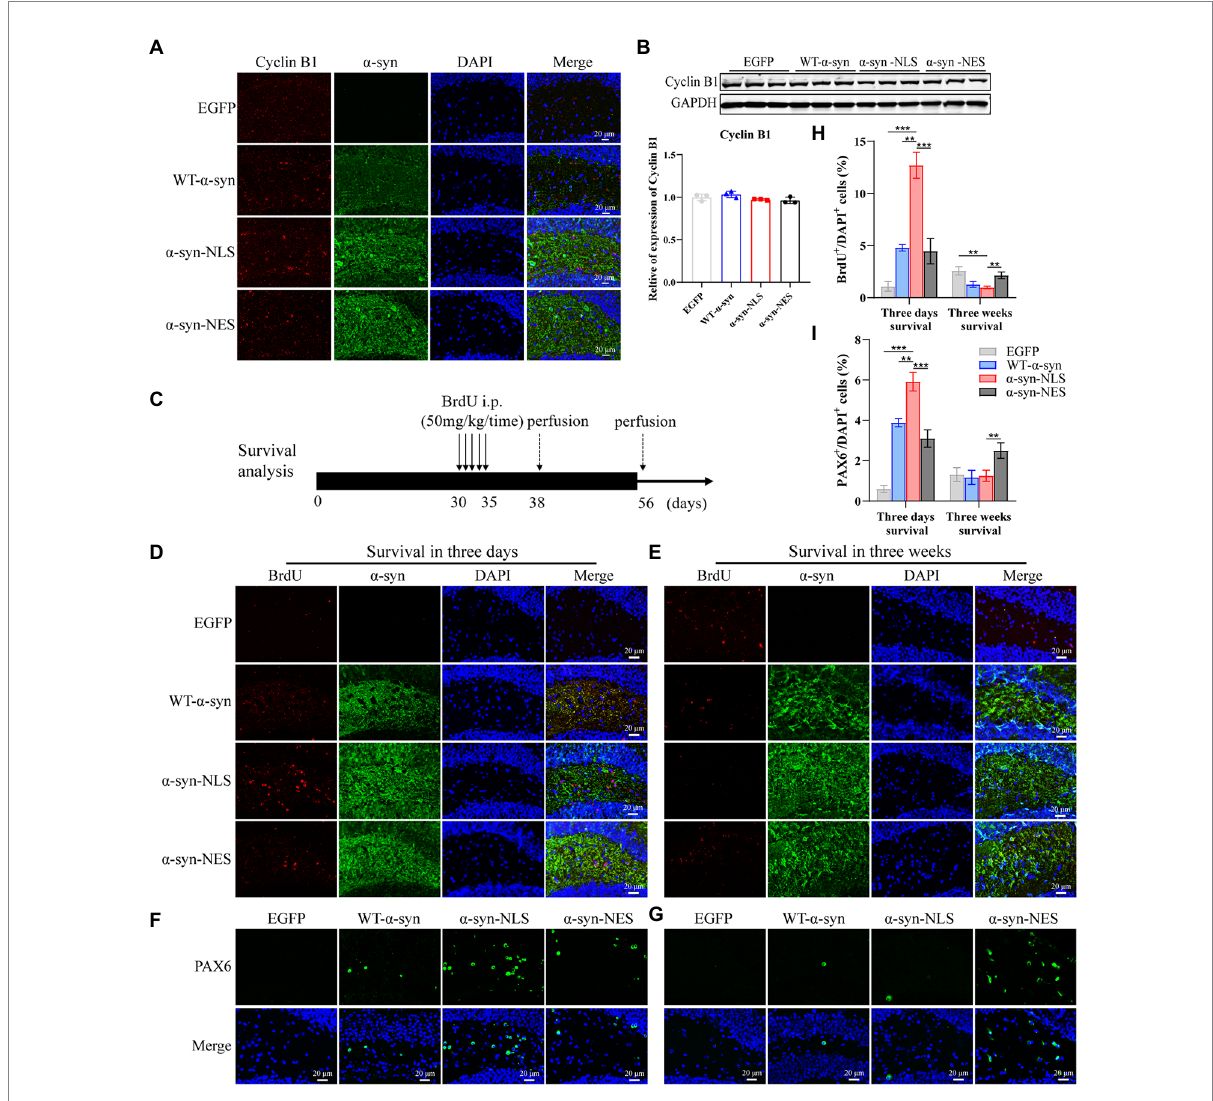
FIGURE 5 Cell cycle progression is blocked before G2 phase and cells exit the cell cycle. (A) The expression of cell cycle G2 phase protein Cyclin B1 was detected by immunofluorescence. (B) Western blot and relative level analysis of Cyclin B1 protein after 1 month of virus injection ( n = 3). (C) A pattern diagram for detecting neuronal cell survival. BrdU was injected once a day starting from month 1 after virus injection for five consecutive days. BrdU-positive cells were examined on day 3 (survival 3-days) and day 21 (survival 3-weeks) after last BrdU injection. (D) Representative BrdU- positive cells on day 3. (E) Representative BrdU-positive cells on day 21. (F) Representative PAX6-positive cells on day 3. (G) Representative PAX6- positive cells on day 21. (H) BrdU + cells were quantified of three-days survival and three-weeks survival ( n = 4). (I) PAX6 + cells were quantified of three-days survival and three-weeks survival ( n = 4). ** p < 0.01, *** p <